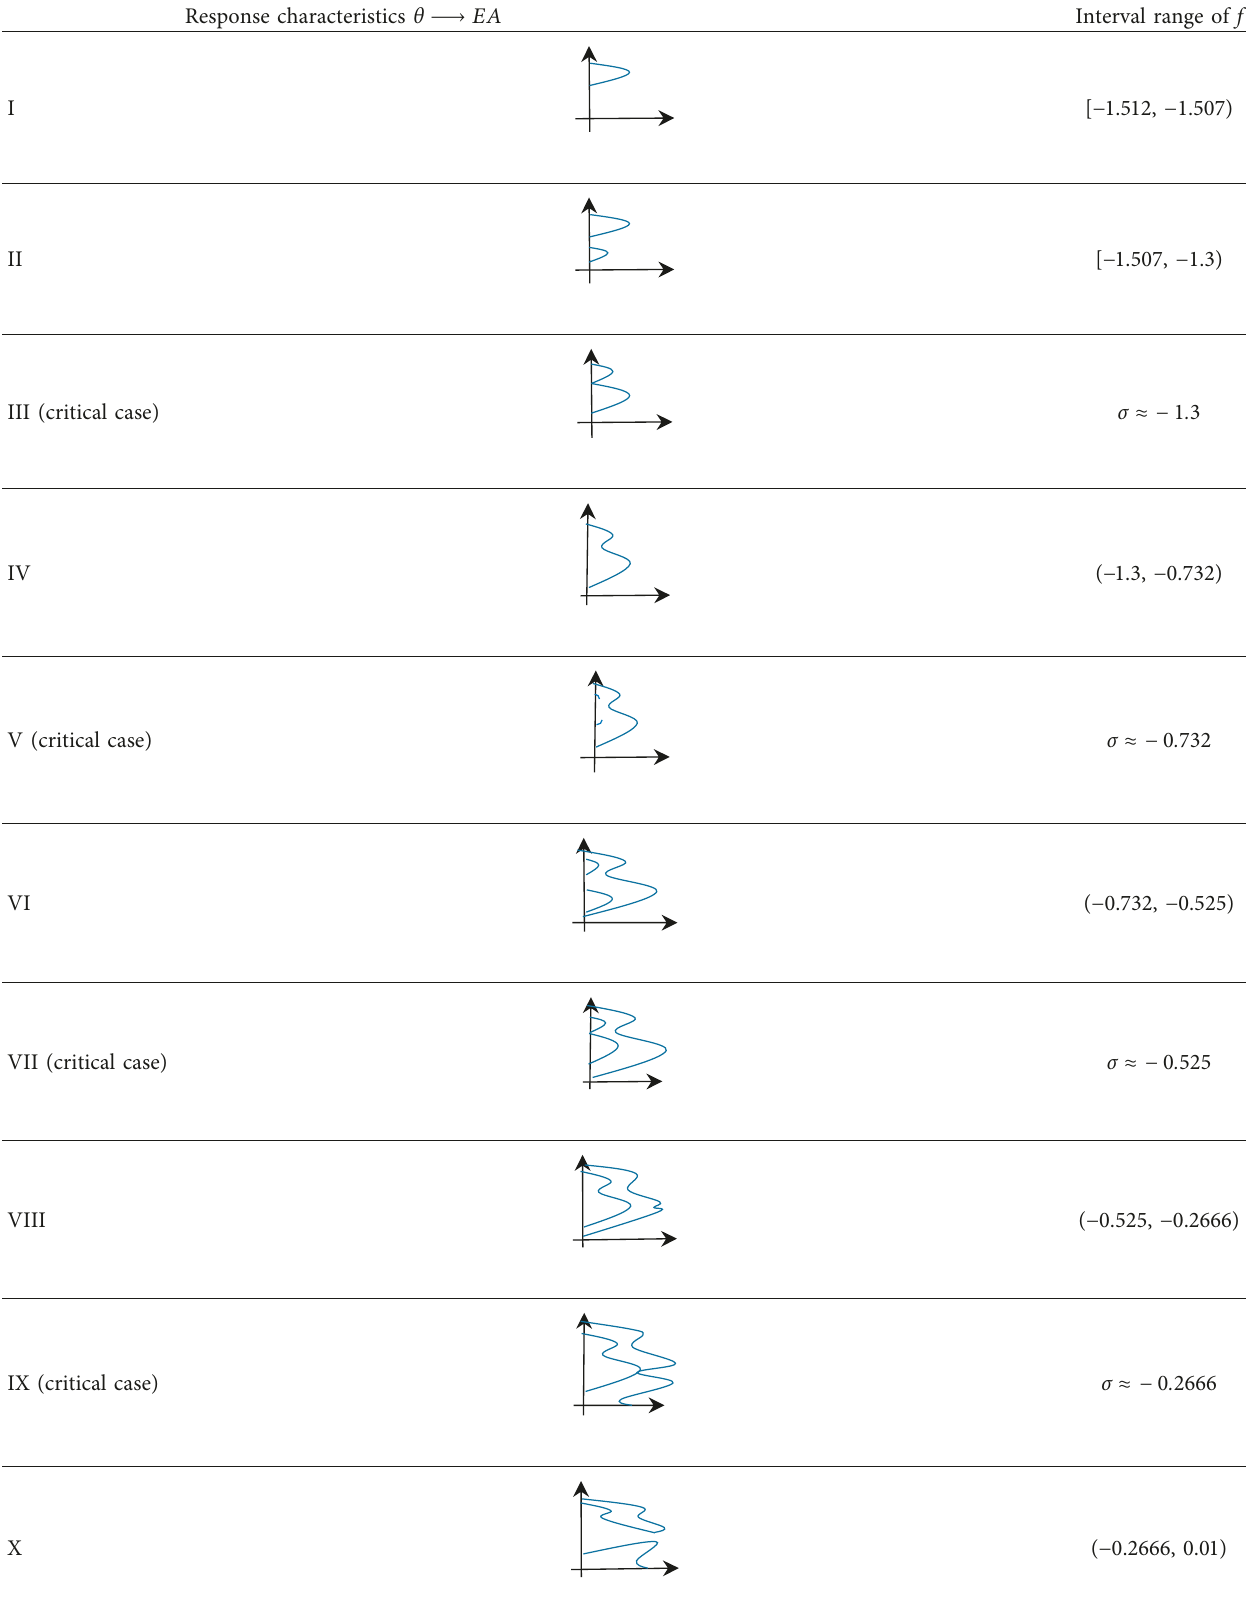
Table 1: Response characteristics shown in Figure